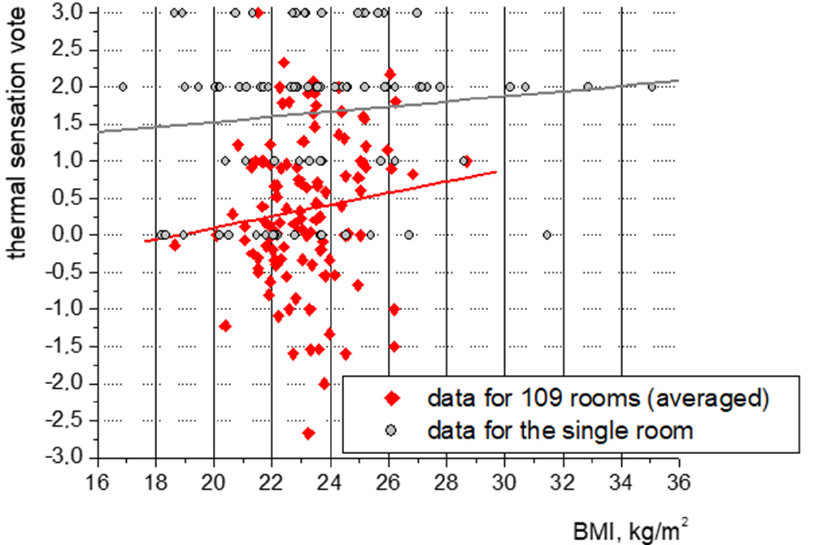
Figure 18. Relation between thermal sensation vote and BMI index for the single room and for 109 rooms, the red line represents linear fitting for the single room data, while the grey line for 109 rooms.